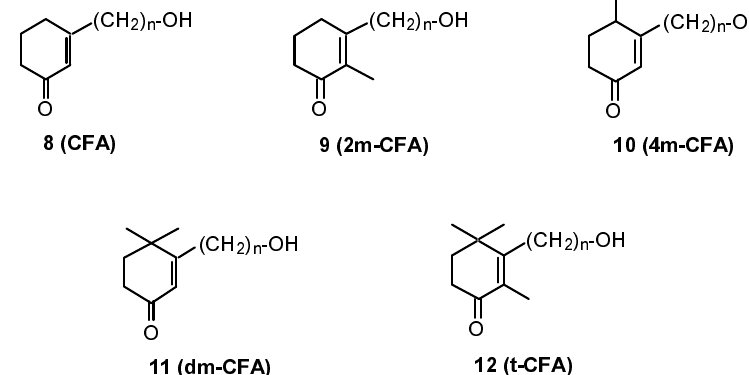
Figure 3. Structure of diverse cyclohexenonic long-chain fatty